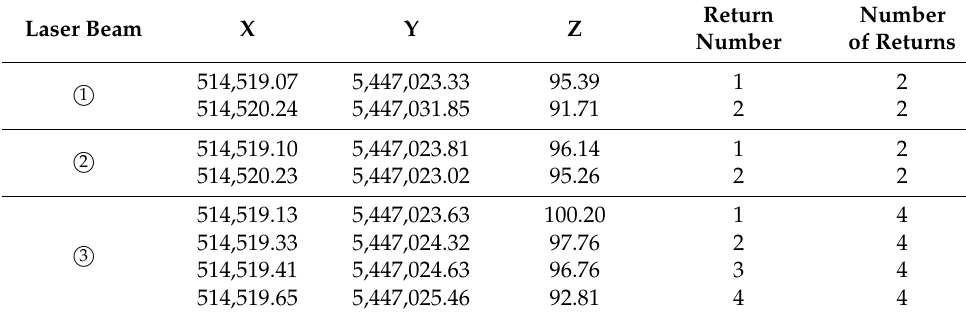
Table 1. Example of return number and number of returns of LiDAR